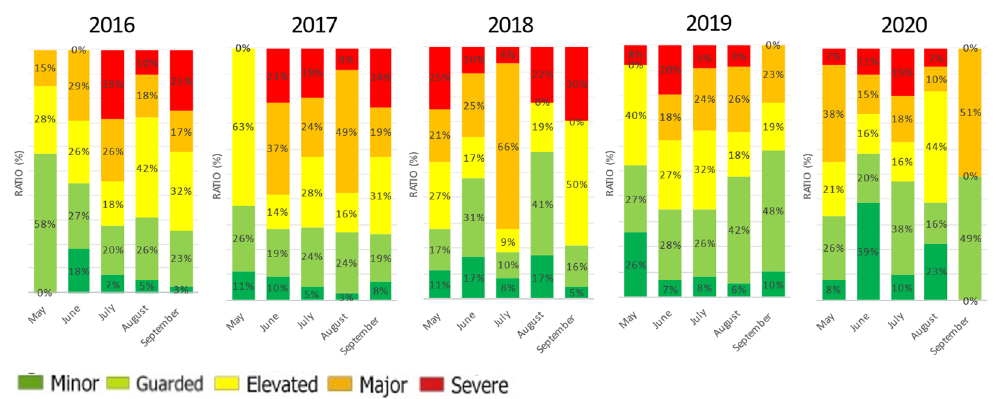
Figure 7. The rational representative percentage of ignitions per associated representative area.